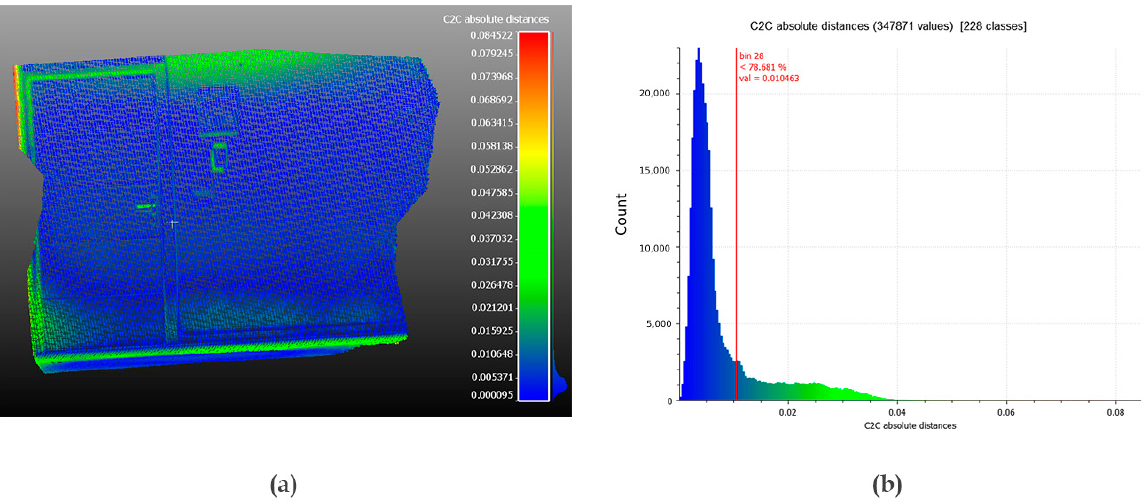
Figure 10. Comparison of the point cloud extracted from the Kinect Azure to the cloud from the TLS: ( a ) the differences between the two clouds [in m], ( b ) histogram of the values [in m].